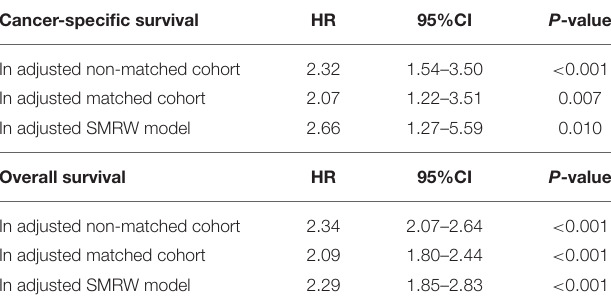
TABLE 2 | Effect of cryoablation vs. radical prostatectomy on oncologic